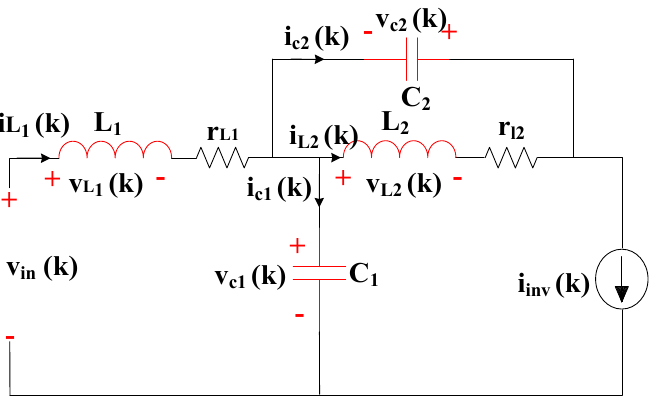
Figure 2. qZSI circuit in the active states.